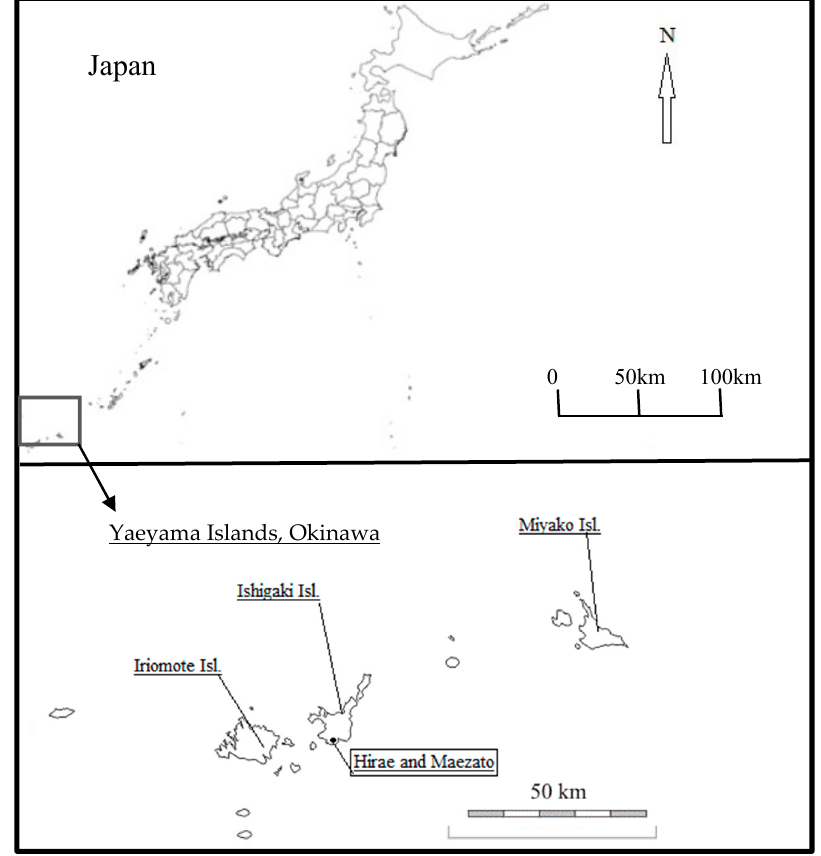
Figure 1. Location of Hirae and Maezato villages. 3